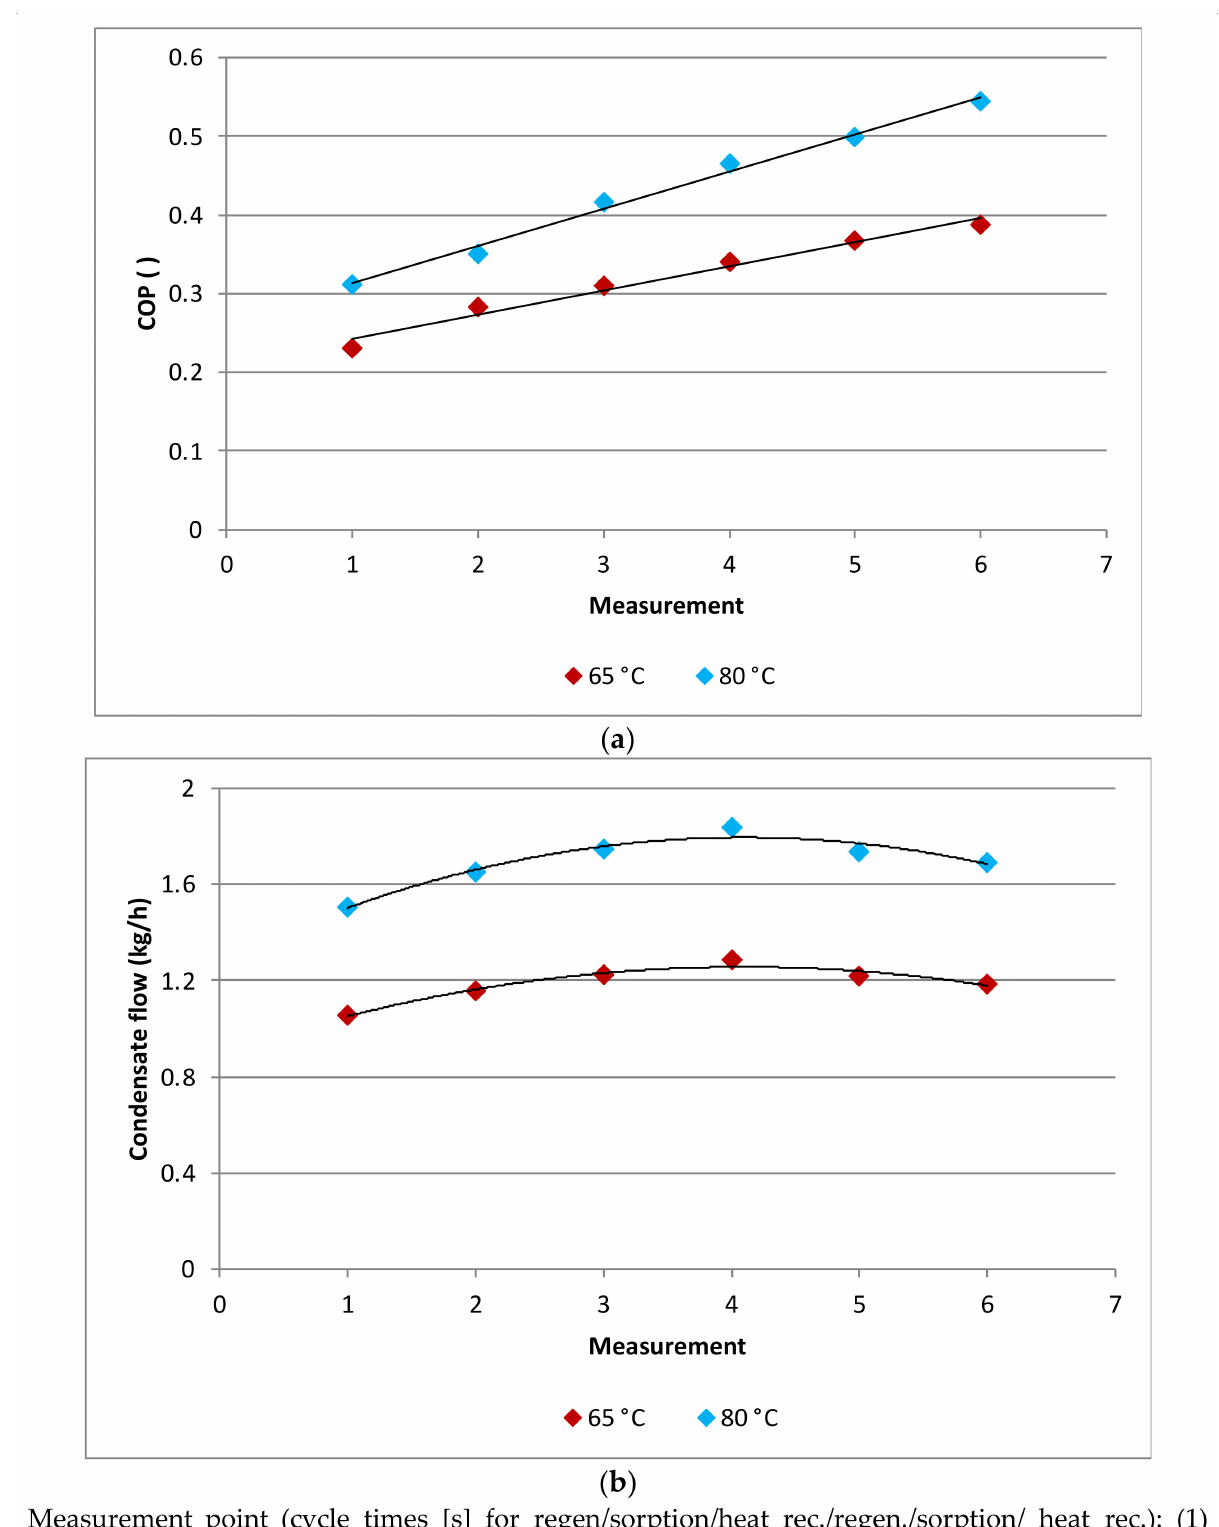
Figure 10. Experimental testing results in GROUP 2 at the hot water temperatures of 80 ◦ C and 65 ◦ C: ( a ) COP; ( b ) conden- sate